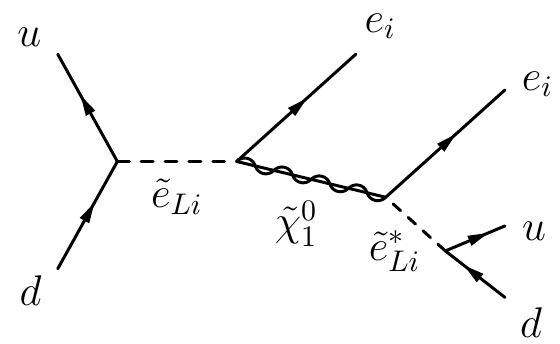
) production and decay through Figure 1 . Parton-level Feynman diagram for the neutralino ( ˜ χ 0 1 the λ 0 coupling at the LHC. The slepton ( ˜ e ) in the left-hand side of the diagram decays into a Li i 11 neutralino and a prompt, charged lepton. We trigger on this prompt lepton while the decay products of the long-lived neutralino are identified as displaced tracks. In this scenario, the neutralino is long- lived as a result of its small mass, the off-shell propagator of the heavy slepton ( ˜ e ∗ ), and the small Li RPV coupling. We note that diagrams with a positively charged s -channel slepton decaying into the neutralino, or with a neutralino decay into e + ¯ ud , are i